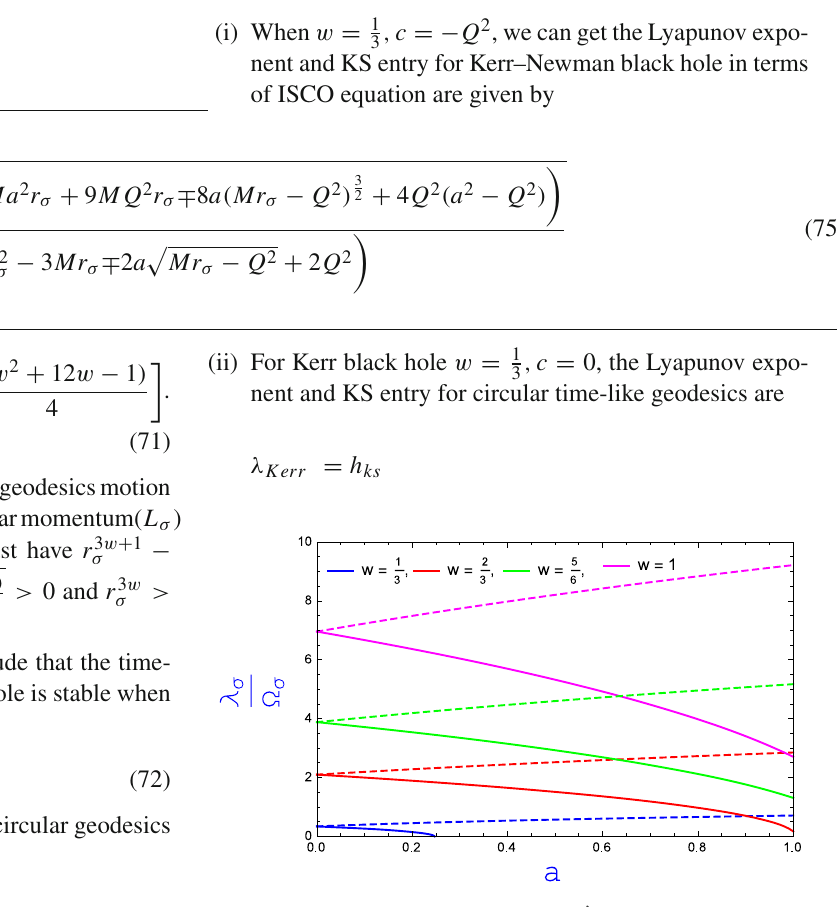
Fig. 1 Dimensionless instability exponent λ σ (cid:9) a for real value of Lyapunov eponent. We use units such that M = 1 , c = 2. Solid lines refer to corotating orbits and dashed lines refer to counterrotating